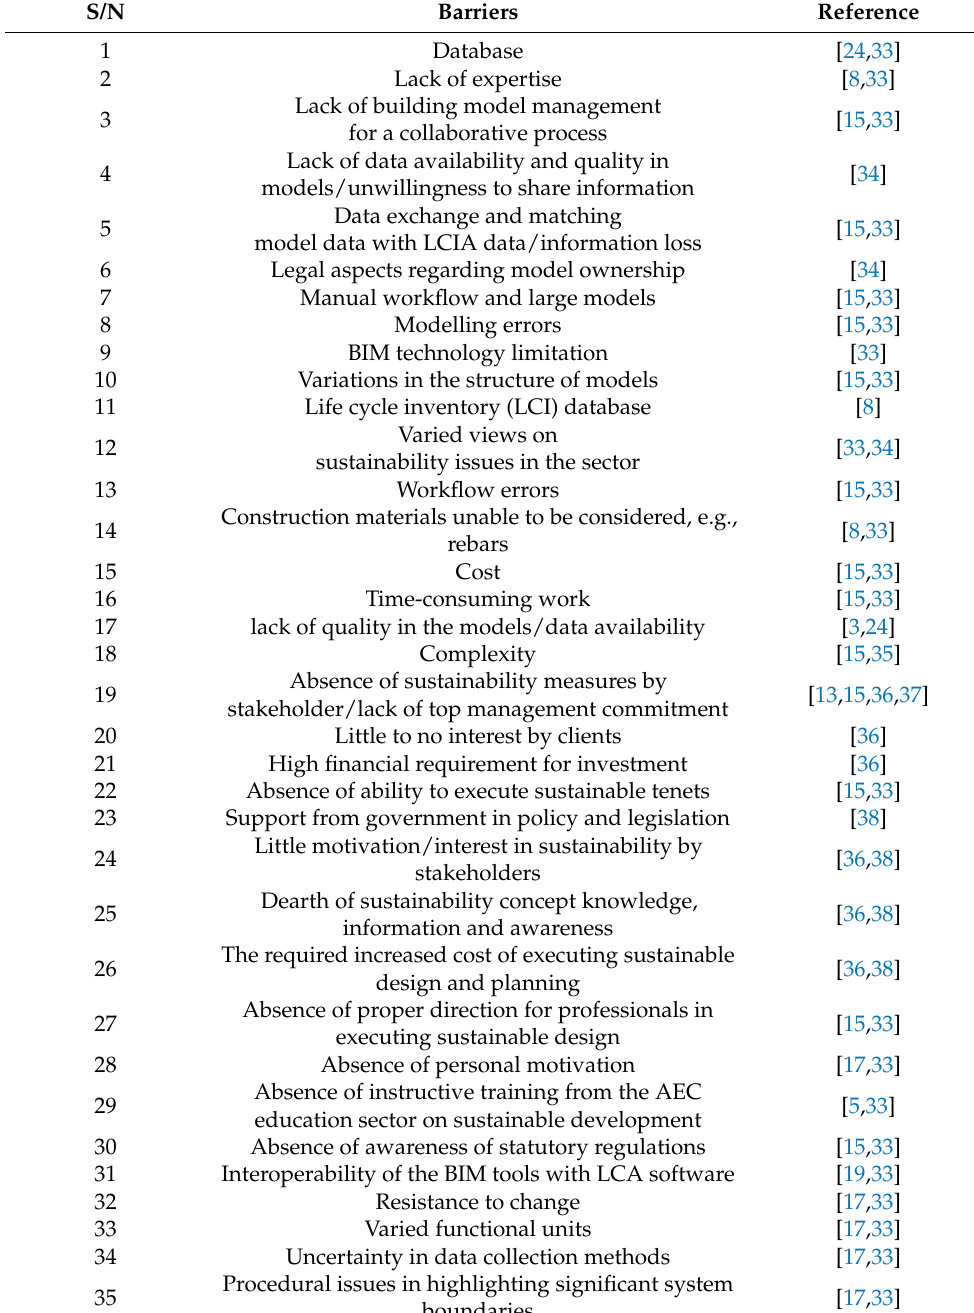
Table 2. Identified barriers to life cycle Sustainability assessment integration with